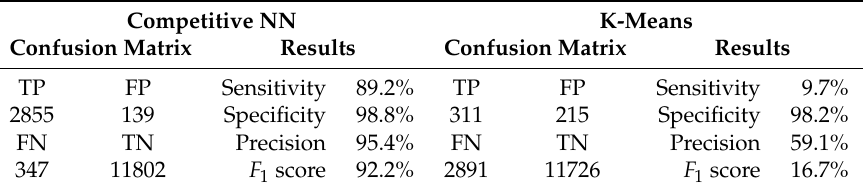
Table 5. Results of training set classification, 25.23 min. with Fs of 10